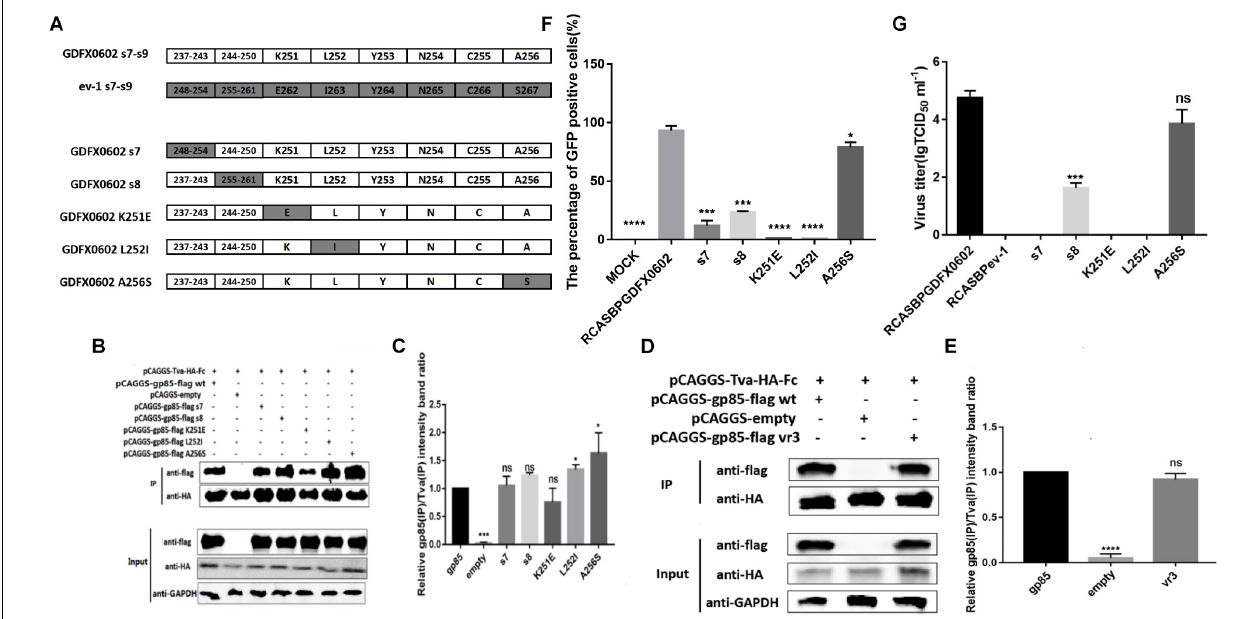
FIGURE 6 | Residues K251 and L252 played a decisive role in the replication of ALV-K in vitro . (A) K251, L252, and A256 of GDFX0602 gp85 were replaced with ev-1 gp85. (B,D) The interaction of soluble chimeric proteins gp85-flag s7, s8, K251E, L252I, A256S and vr3 with Tva-HA-Fc. (C,E) The level of protein was quantified using Image StudioLiteVer 5.2, and soluble chimeric proteins gp85-flag (IP)/Tva-HA-Fc (IP) were calculated. (F) DF-1 cells transfected with recombinant plasmids RCASBP GDFX0602 s7-EGFP, RCASBP GDFX0602 s8-EGFP, RCASBP GDFX0602 K251E-EGFP, RCASBP GDFX0602 L252I-EGFP, and RCASBPGDFX0602 A256S-EGFP were detected for the percentage of GFP-positive cells by fluorescence-activated cell sorting. (G) The supernatant was collected and diluted in gradient to determine the virus titers. Three independent experiments were performed, and data are shown as mean ± SD in triplicate from a representative experiment. Statistical analysis (two-way analysis of variance) was performed using GraphPad Prism 7; * P < 0.05, *** P < 0.001, **** P < 0.0001, ns P > 0.05.